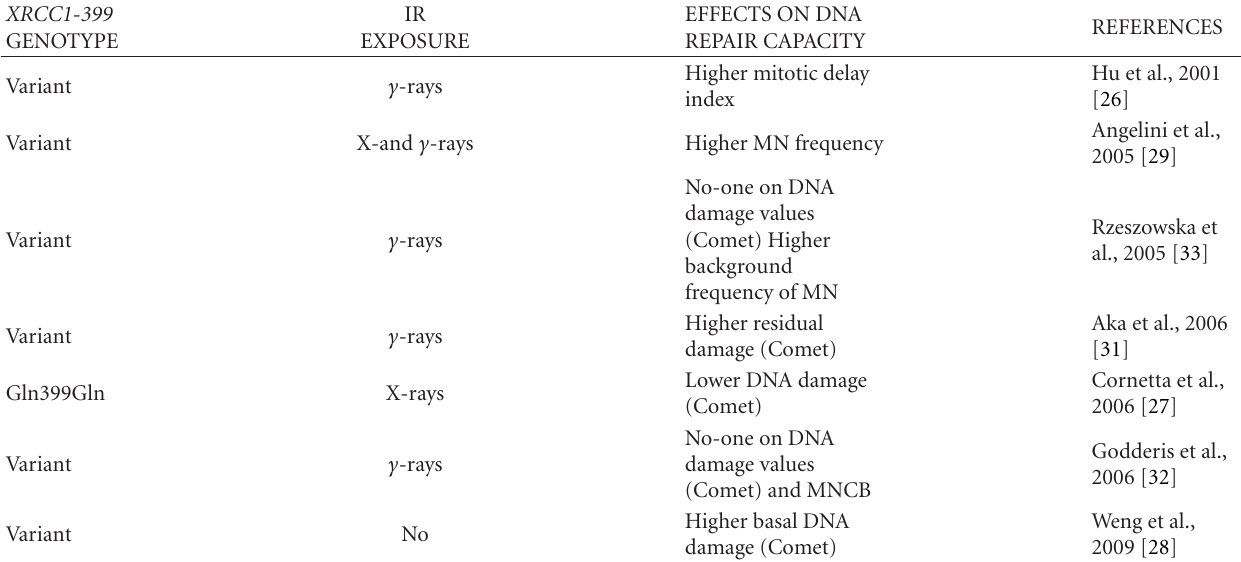
Table 1: Reported studies about the association of XRCC1-399 polymorphism and DNA repair capacity.